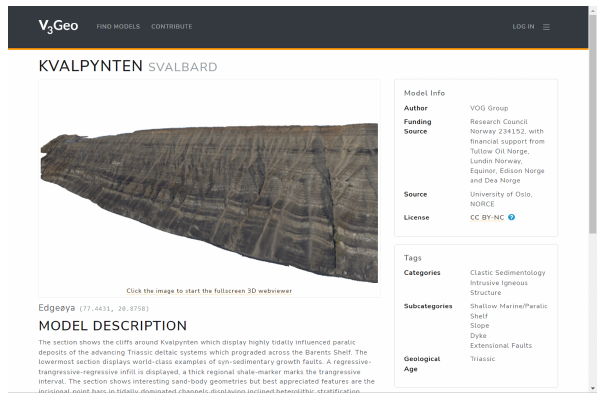
Figure 2. Model page on V3Geo, showing metadata, model de- scription, tags and image carousel serving as a hyperlink to launch the 3D model viewer. The example shown is from Kvalpynten, Edgeøya, Svalbard (Anell et al., 2021; Kvalpynten, VOG Group, https://v3geo.com/model/90, last access: 6 February 2022, CC BY-